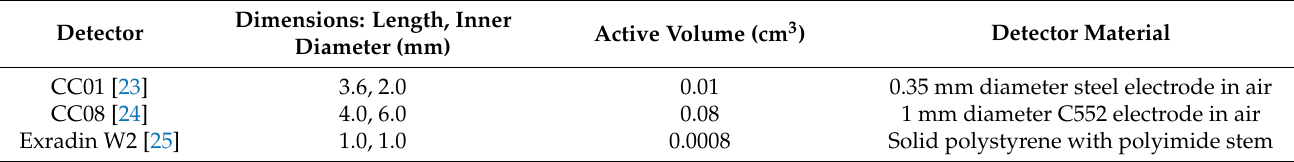
Table 1. Physical properties of the detectors used and